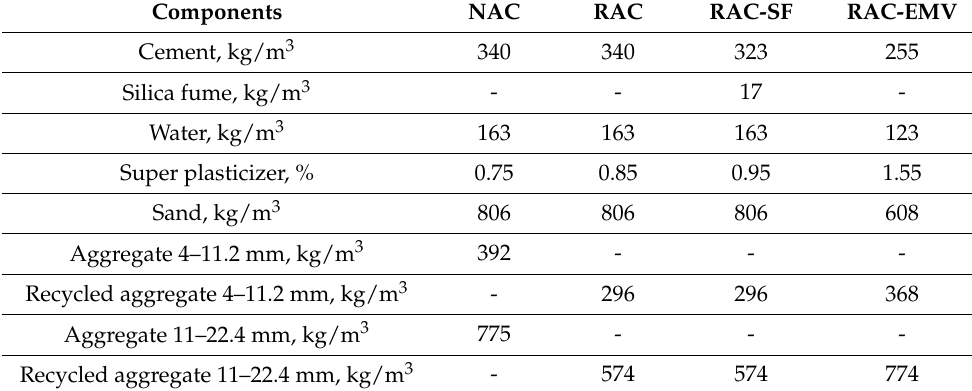
Table 4. Ingredients of mixes.